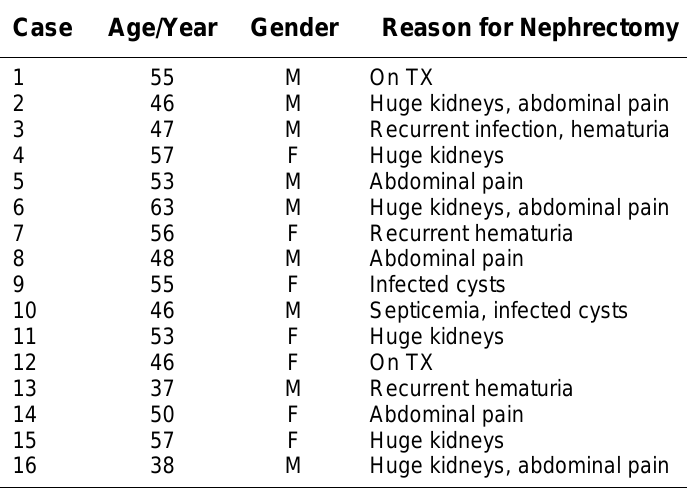
Clinical Data of the Study ADPKD